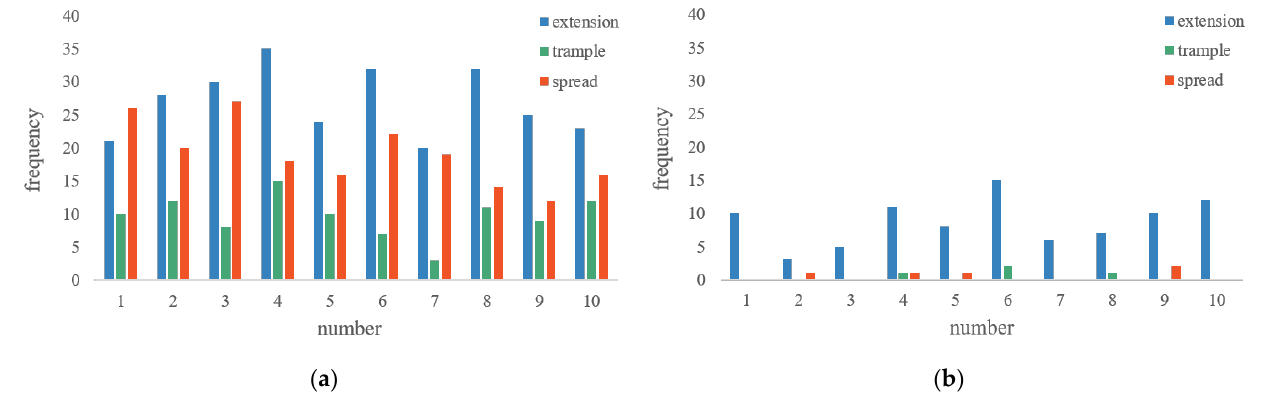
Figure 15. Statistics of behavior occurrence frequency. ( a ) frequency of behavior in emergency, ( b ) frequency of behavior in non-emergency.